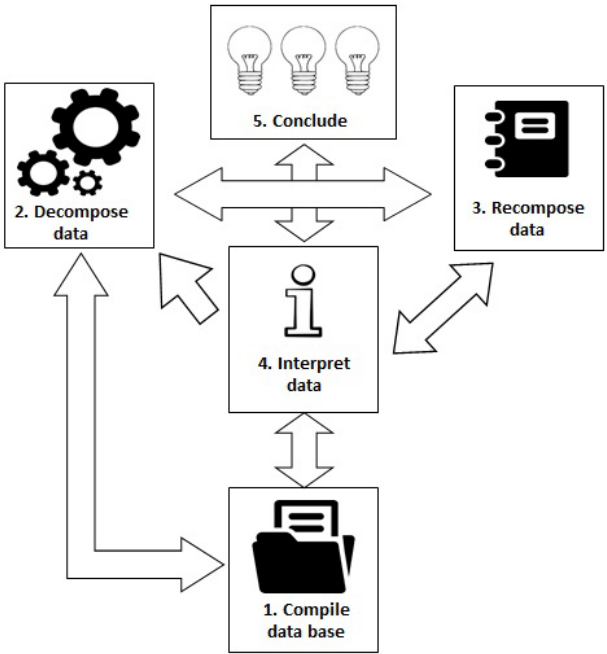
Figure 5. Five phases of analysis and their interactions (based on Yin,